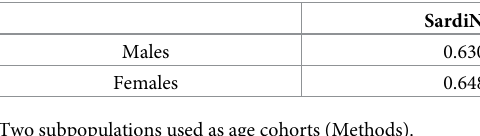
Two subpopulations used as age cohorts